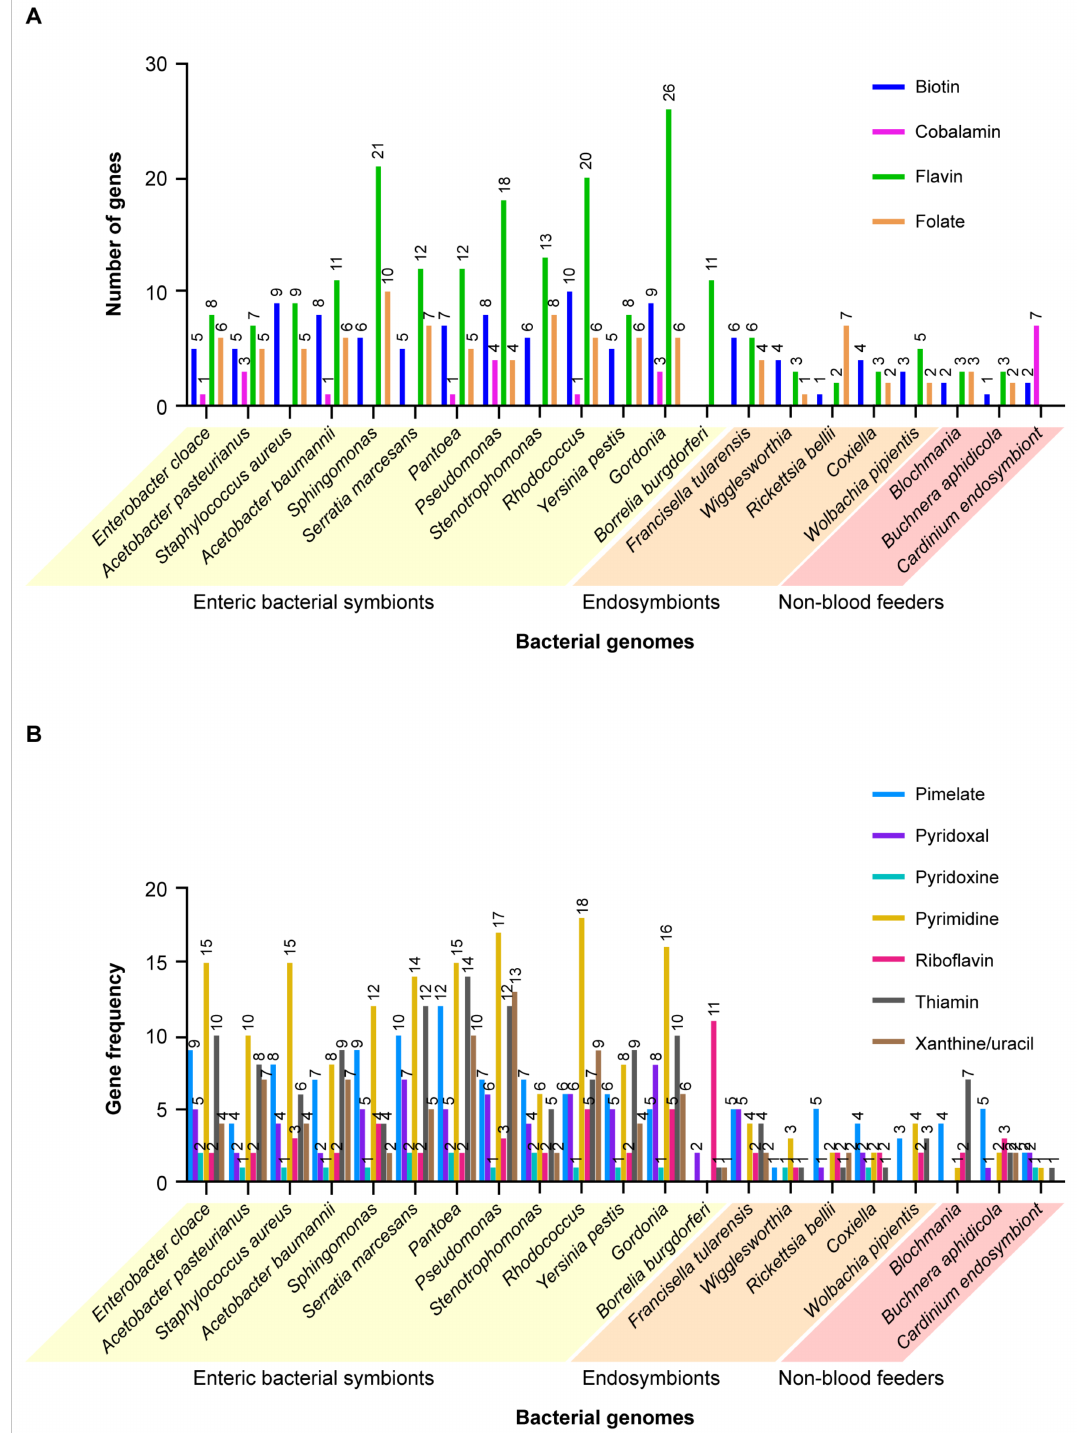
Figure 5. Comparison of the number of genes coding for different vitamins expressed by 18 symbiotic bacteria in blood- feeding insects and ticks versus three symbiotic bacteria in plant-feeding insects. Differences between enteric bacterial symbionts versus endosymbionts also are compared. ( A ) Biotin, cobalamin, flavin and folate. ( B ) Pimelate, pyridoxal, pyridoxine, riboflavin, thiamin and xanthine/uracil. Results show bacterial symbionts (both enteric and endosymbiont) in blood-feeding arthropods express significantly more genes coding for diverse vitamins than non-blood feeding